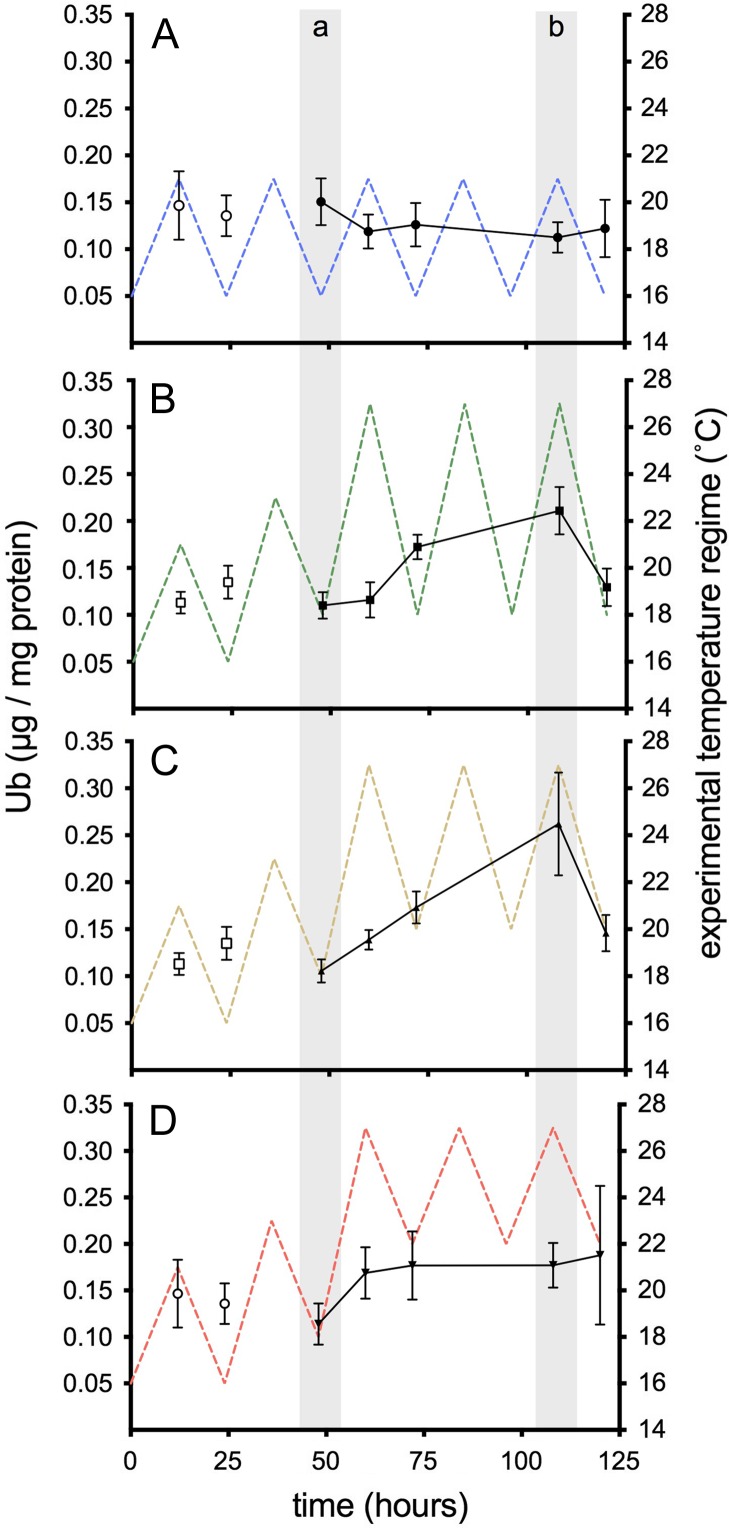
Liver Ub in juvenile salmon exposed to diel cycles: (A) 16–21°C only; or multi-day thermal stress (closed symbols; 60–120 h) of (B) 18–27°C; (C) 20–27°C; (D) 22–27°C. Data are presented as mean ± SEM (n = 6–9). Pre-thermal stress sampling (open symbols; t = 12 and 24 h) assessed the effect of ‘trial’ and was not included in the analysis. Lettered shaded bars indicate significant differences between time points (P < 0.05).